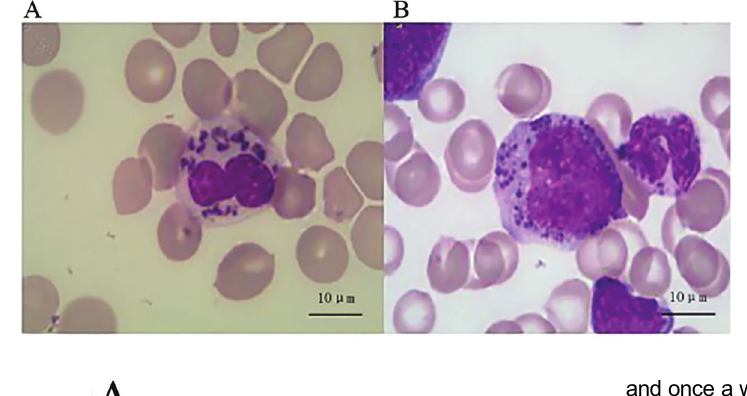
Figure 3. Abnormal intracytoplasmic giant granule in granular leukocytes in peripheral blood smear ( A ) and in their bone marrow precursors ( B ) by microscopic examination.